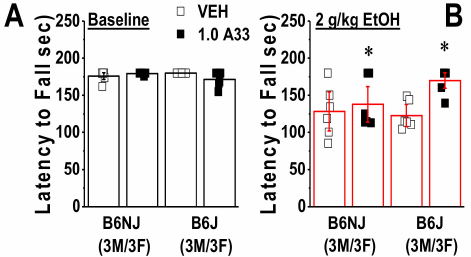
Figure 9. A33 does not affect basal motor coordination, but reduces the intoxicating properties of 2 g/kg alcohol in experimentally-naïve mice. Summary of the effects of pretreatment with either vehicle (VEH) or 1.0 mg/kg of A33 (1.0 A33; 30 min prior) on ( A ) the latency of B6NJ and B6J mice (3 females/3 males/group) to fall from a rotarod under an alcohol-free state and ( B ) following injection with 2 g/kg EtOH (~30 min post-alcohol). The data represent the mean ± SEM of the number of mice indicated, in addition to the individual data points for each experimental group. * p < 0.05 vs. VEH (main